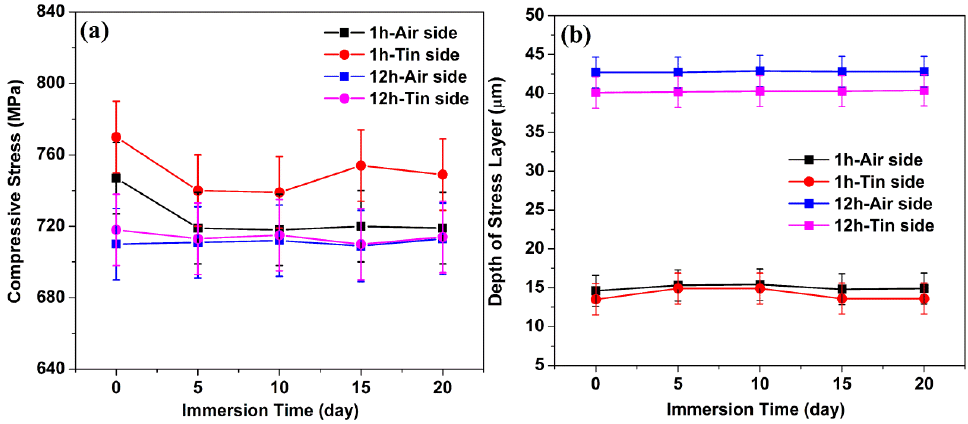
Figure 1. CS ( a ) and DOL ( b ) as a function of immersion time.